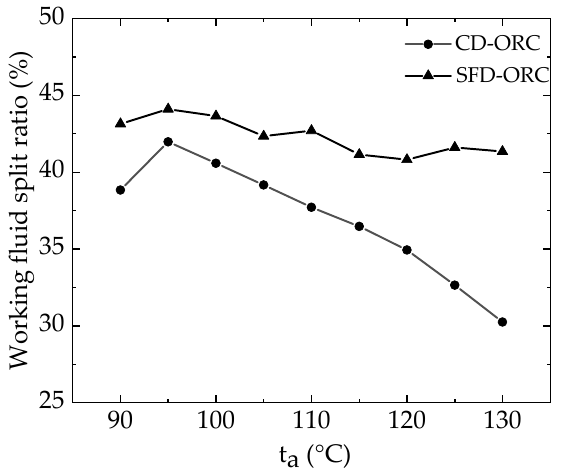
Figure 12. The results of the evaporation temperature at the optimal operating conditions.